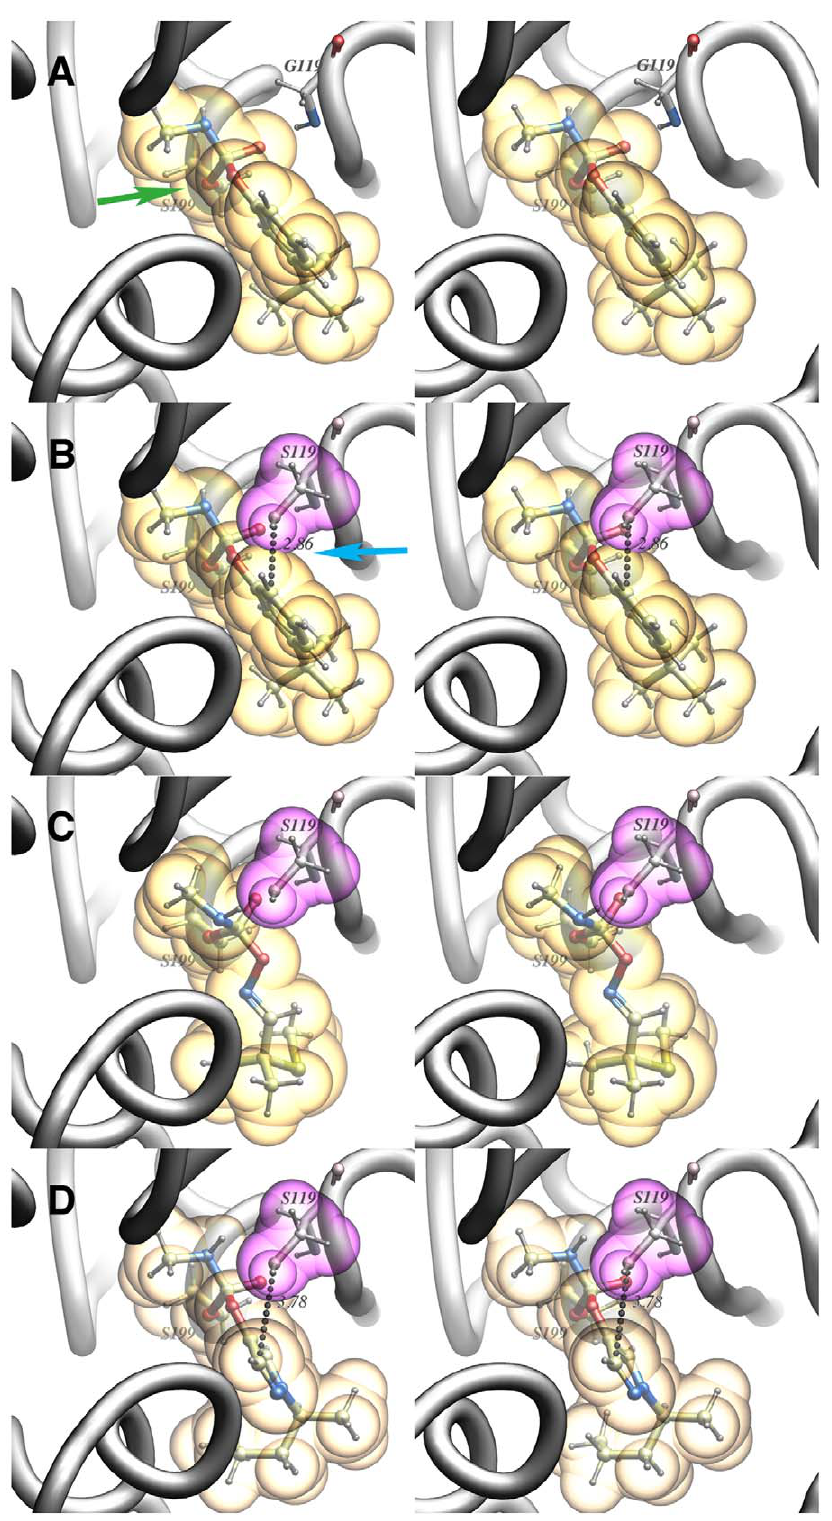
Figure 7. Computational modeling of tetrahedral intermediates formed by addition of the Ag AChE catalytic serine (S199) O c to carbamates. A) terbam with WT enzyme; location of catalytic serine oxygen O c is highlighted with the green arrow. B) terbam with G119S mutant enzyme; steric clash of the hydroxyl group of S119 with aromatic ring of terbam is noted with a blue arrow. C) Aldicarb with G119S mutant enzyme; note the absence of a steric clash with the hydroxyl group of S119. D) Pyrazol-4-yl methylcarbamate 4c (( S )-enantiomer) with the G119S mutant enzyme; note the absence of a steric clash with the hydroxyl group of S119. Nonbonded contact distances in B and D are given in A˚.